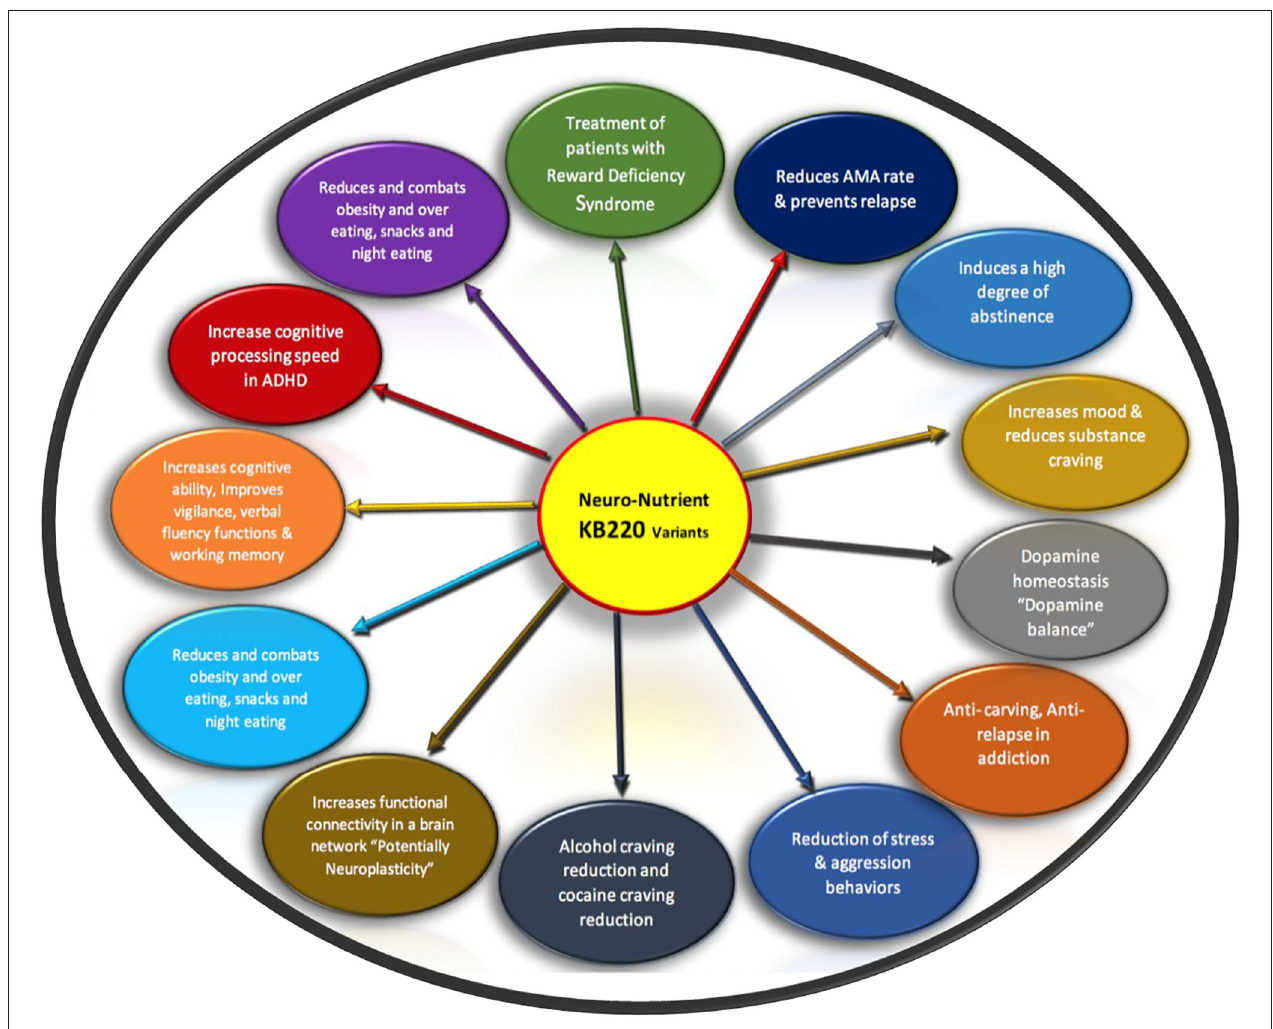
FIGURE 2 | It is a schematic showing list of RDS benefits of KB220 variants Original figure Blum